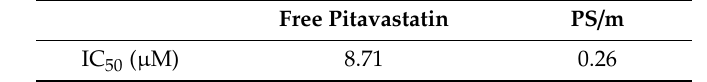
Table 1. The 50% inhibitory concentrations with PS/m and free pitavastatin vs. smooth muscle cell. Free Pitavastatin